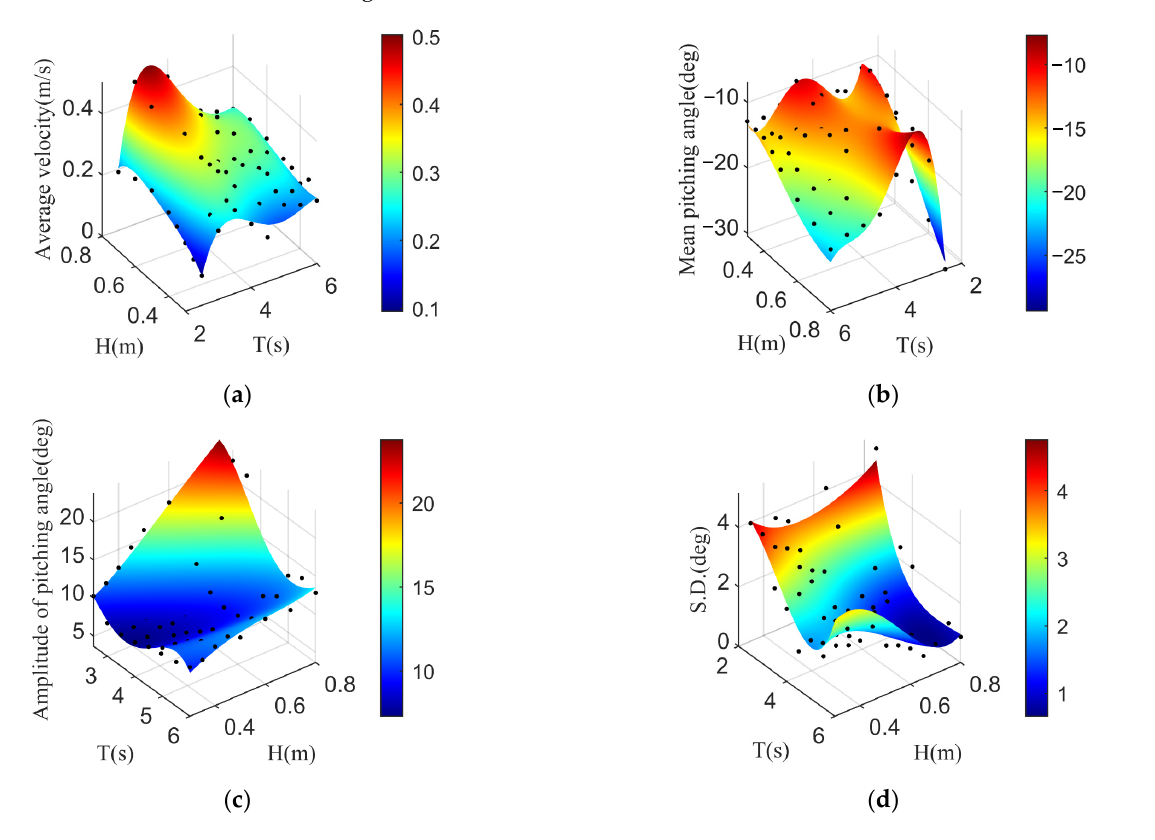
Figure 23. Numerical simulation results for longitudinal motion under different sea states, the black dots are numerical simulation data, and the continuous colorful planes are generated after interpolation about numerical simulation data: ( a ) the longitudinal average velocities of the wave glider; ( b ) the mean pitching angles of the submerged glider; ( c ) the pitching angle amplitude of the submerged glider; ( d ) the standard deviation of the pitching angle.